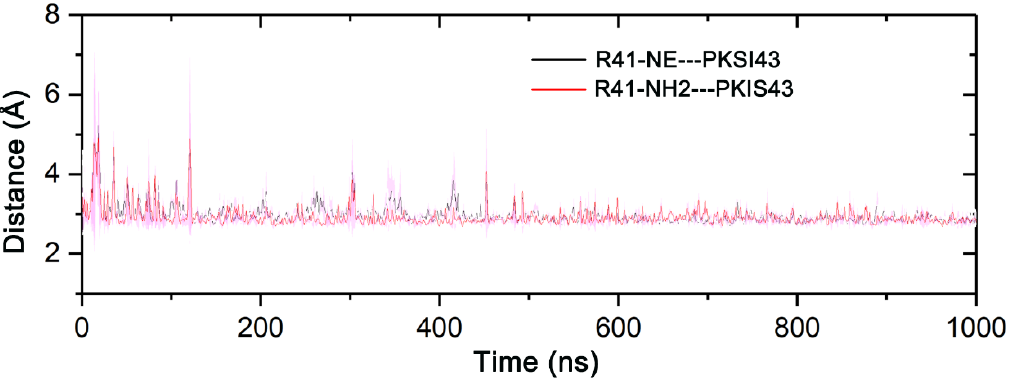
Figure 7. The distances between the NE atom of Arg41 and the carboxylate oxygen atom of PKIS43 as well as between the NH2 atom of Arg41 and the carboxylate oxygen atom of PKIS43, averaged over four independent runs. Transparent shade represents standard deviations.